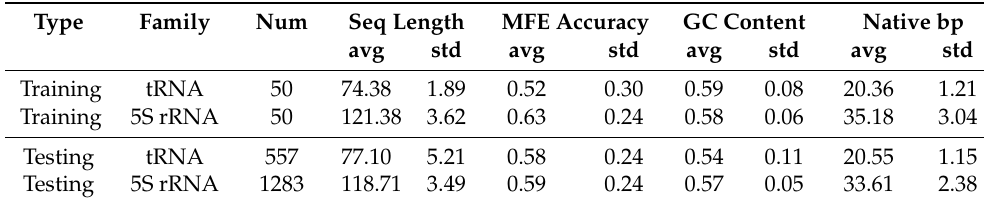
Table 1. Per family characteristics of the training and testing data